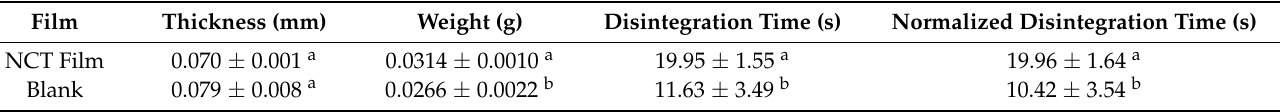
Table 2. Thickness, weight, and disintegration time of NCT fast dissolving films.